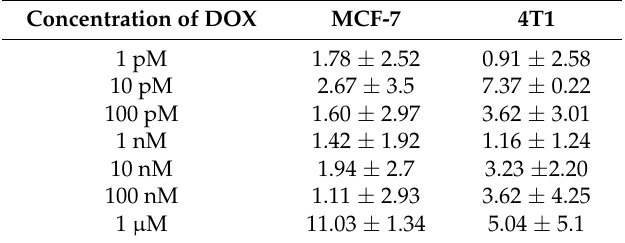
Table 2. Enhancement of cytotoxicity (%) for DOX-loaded CA (Carbonate apatite) NPs.